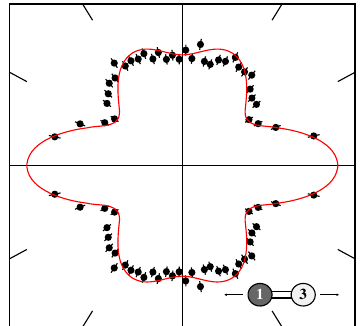
FIG. 4. Polarization-averaged molecular-frame angular distri- bution of the first photoelectron emitted in the overall process. The molecule is aligned horizontally with the triply charged O 3 þ ion located on the right. The XFEL photon energy is set to h ν ¼ 670 eV, yielding a K -shell electron of approximately 127 eV kinetic energy. The red line is the result of our full theoretical